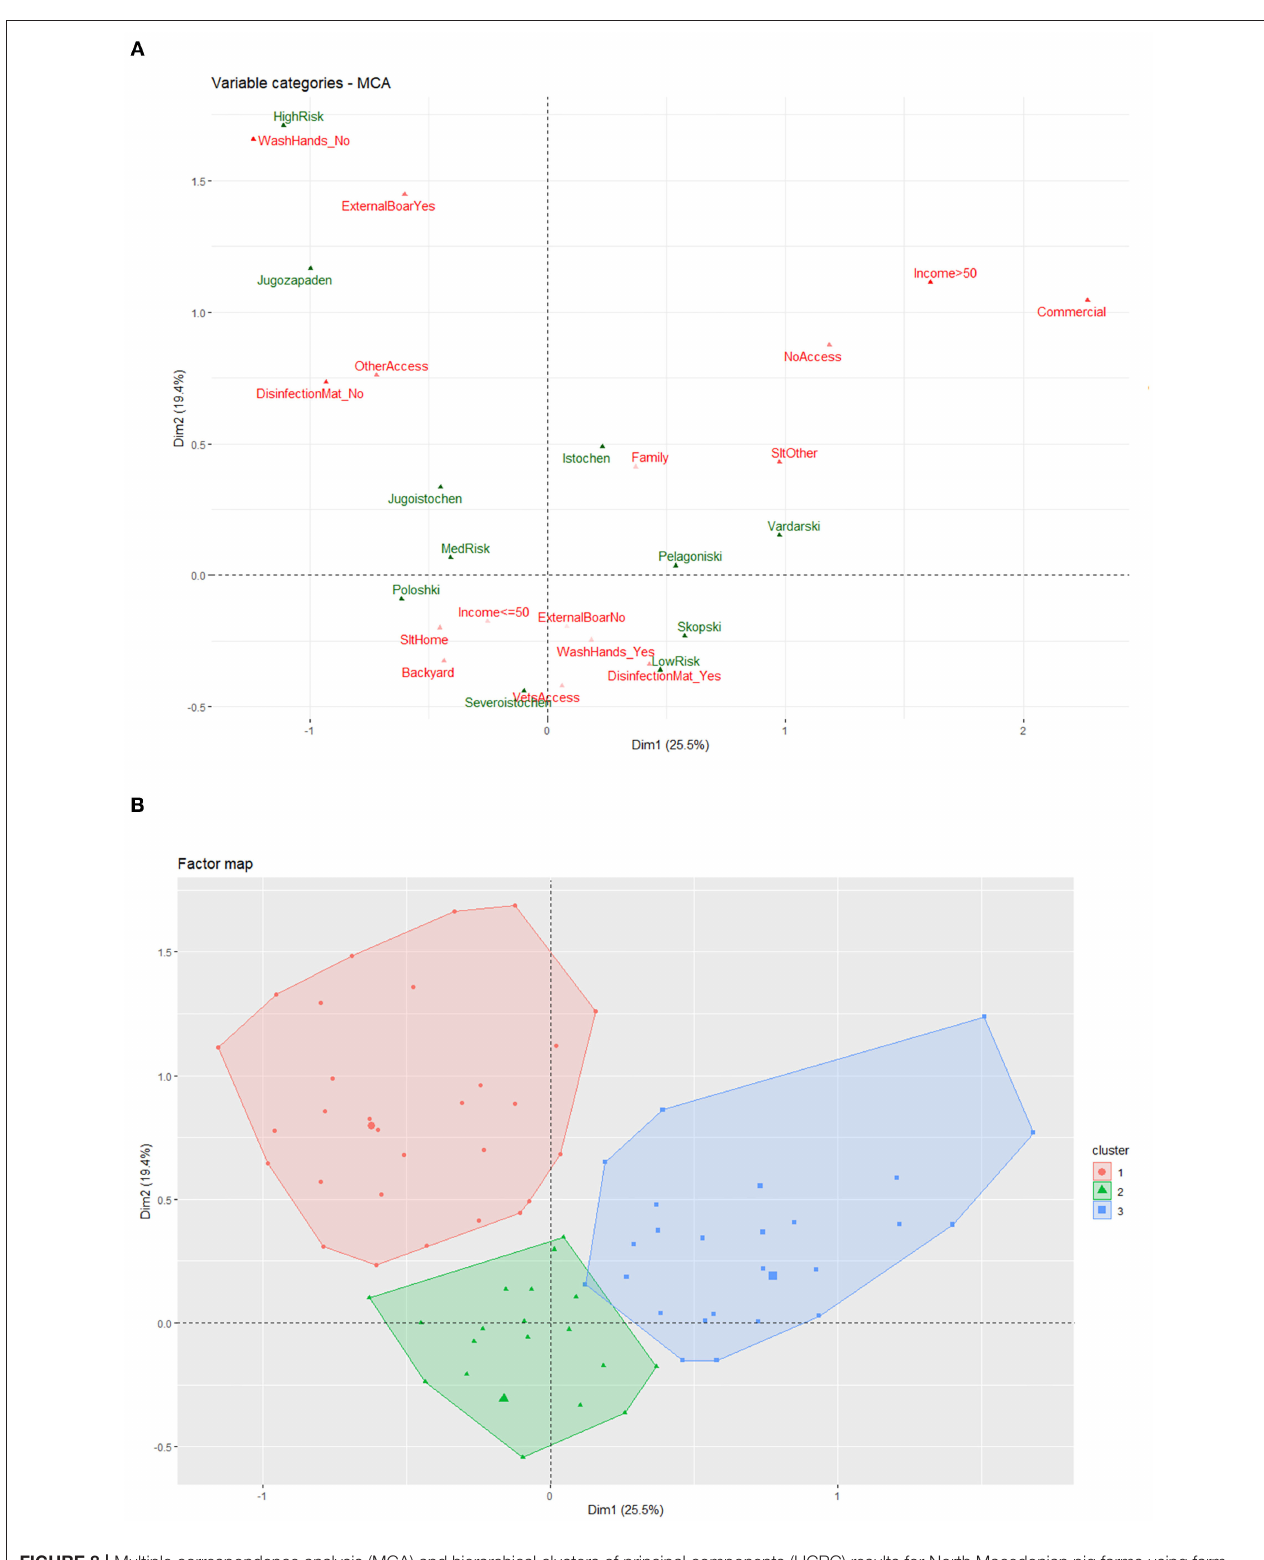
FIGURE 8 | Multiple correspondence analysis (MCA) and hierarchical clusters of principal components (HCPC) results for North Macedonian pig farms using farm characteristics and practices reported in questionnaires administered between September 2019 and March 2020, with region and biosecurity risk score